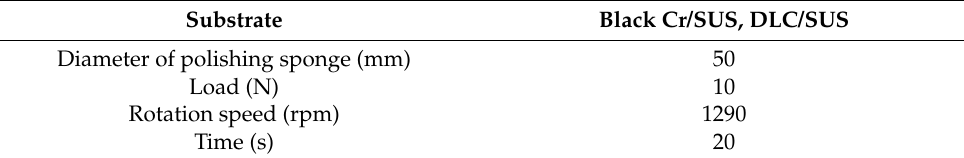
Figure 3. Schematic of the cleaning test. Table 2. Conditions of the cleaning test.